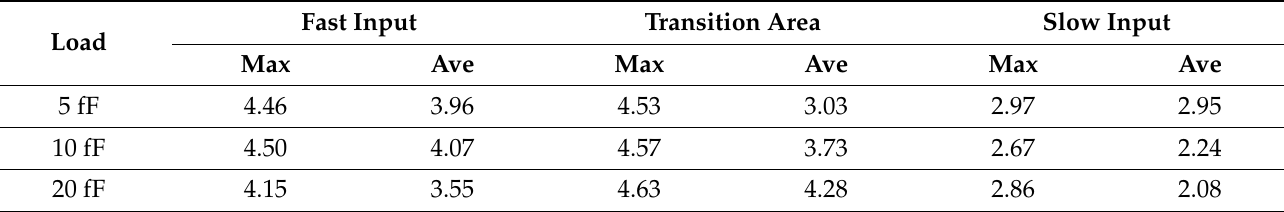
Table 4. Error of max inverter delay at 3 σ percentile point